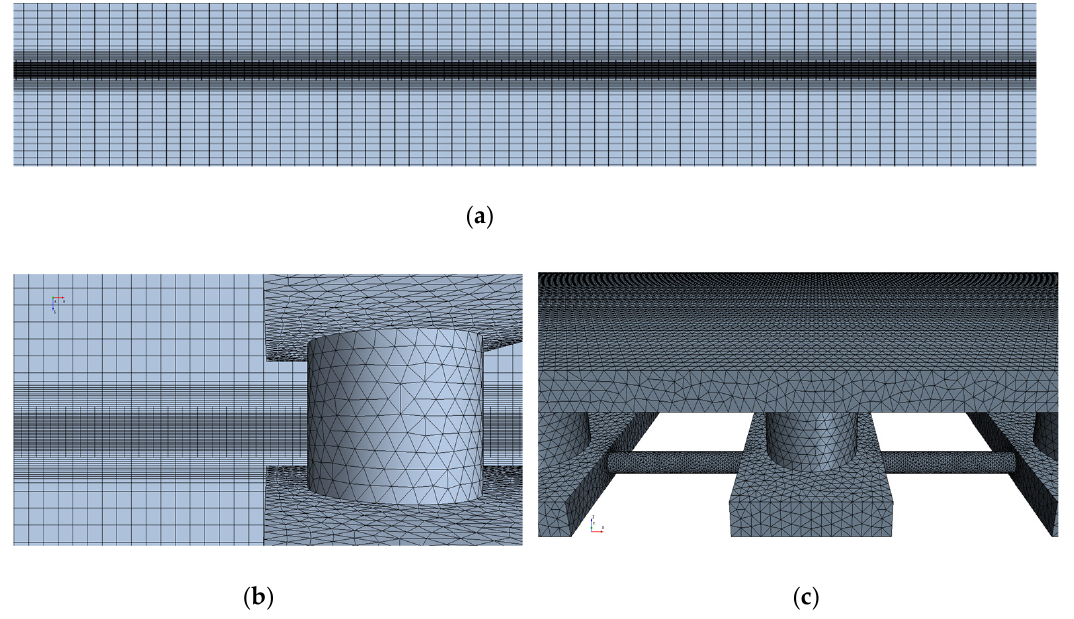
Figure 4. Flow field mesh and floating body mesh cell division. ( a ) Fluid area meshing; ( b ) Two layers of waterline encryption grid location; ( c ) Floating body grid.